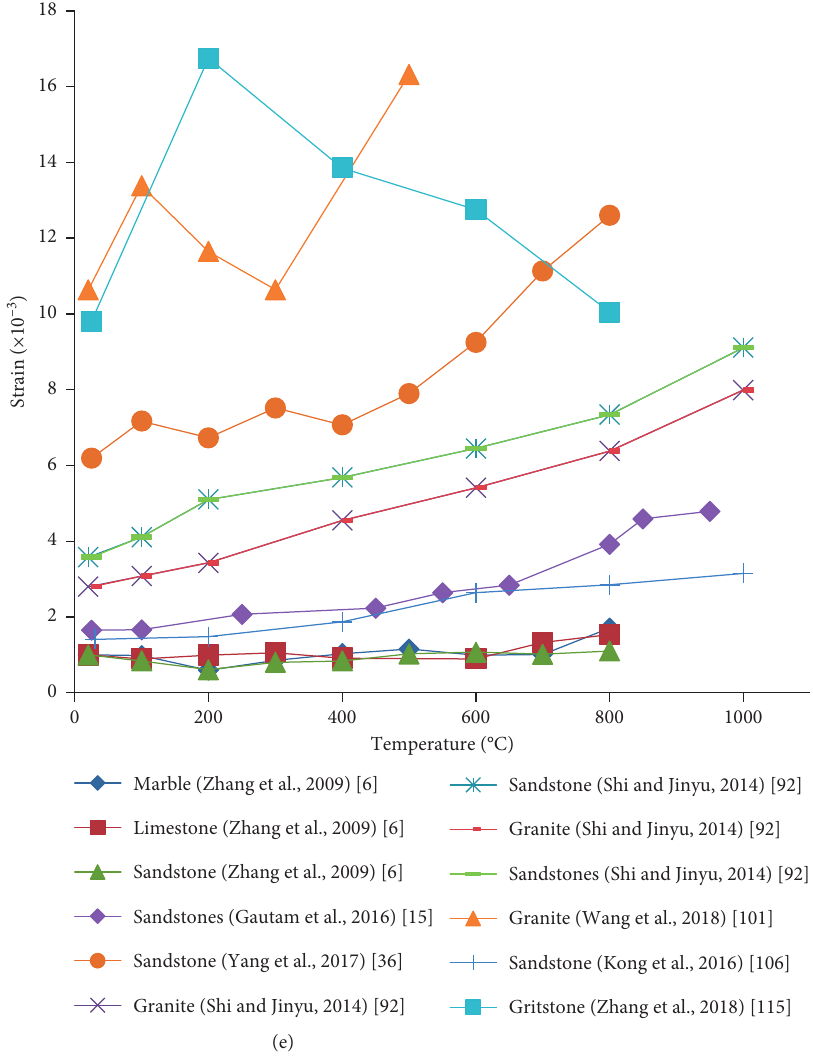
Figure 9: Stress-strain curves at high temperature of (a) marble [6], (b) granite [111], (c) limestone [6], (d) sandstones [111], and (e) peak strain-temperature curves of certain rocks